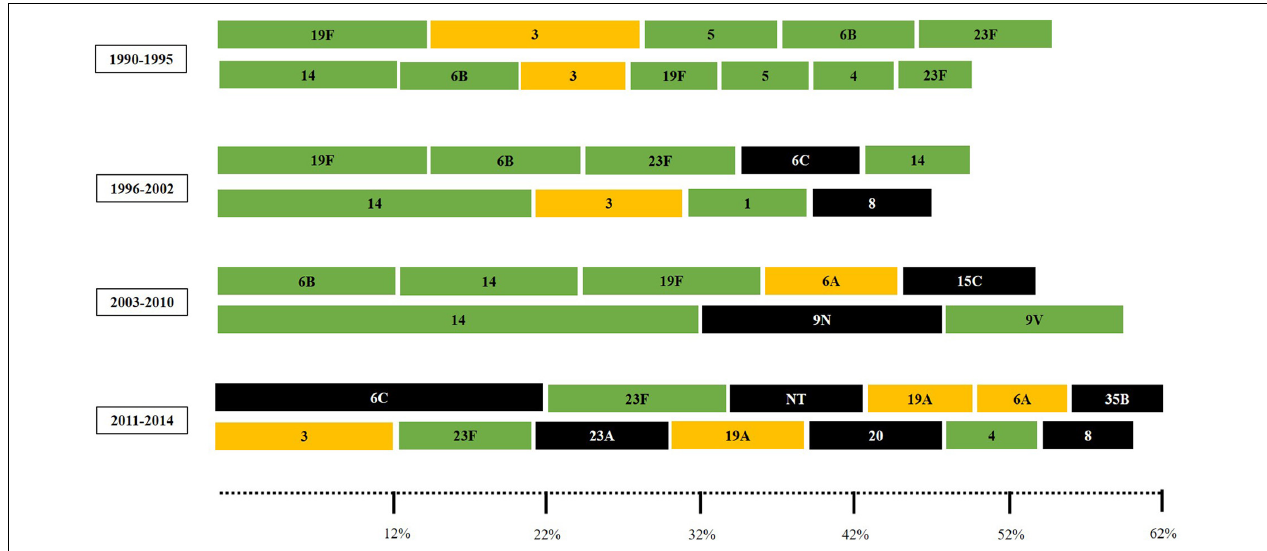
FIGURE 1 | The most common pneumococcal capsular types (comprising 50 to 60% of the pneumococcal isolates) according to the clinical source and period of time. Carriage isolates (represented in the upper lines) included strains recovered from nasopharynx or oropharynx specimens while IPD (invasive pneumococcal disease) isolates (represented in the bottom lines) included strains recovered from blood or cerebrospinal fluid. Serotypes colored in green are included in the 10-valent pneumococcal conjugate vaccine (PCV); those colored in yellow are only included in the 13-valent PCV; and those colored in black are not included in any PCV currently